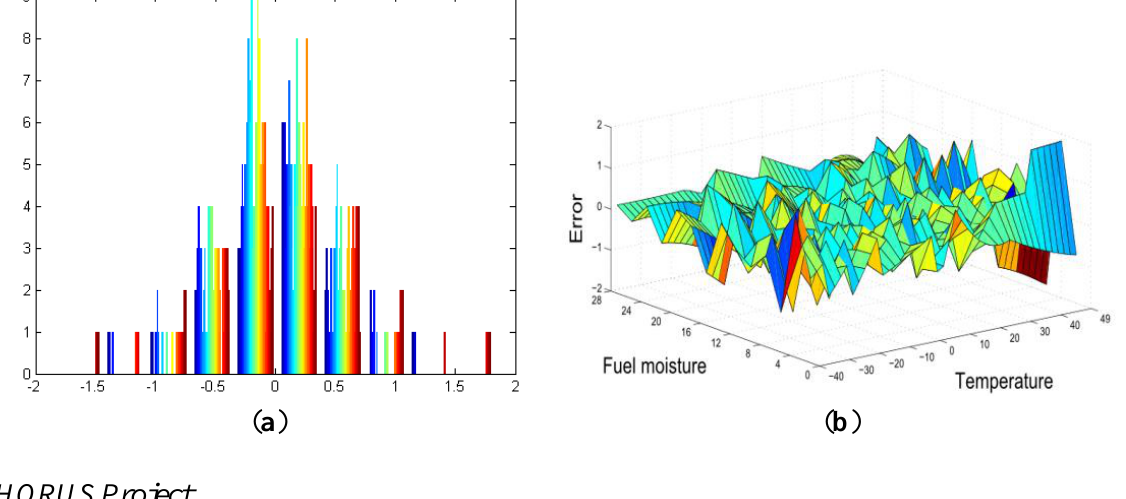
Figure 14. Error comparison. ( a ) Histogram error; ( b ) Dimensional